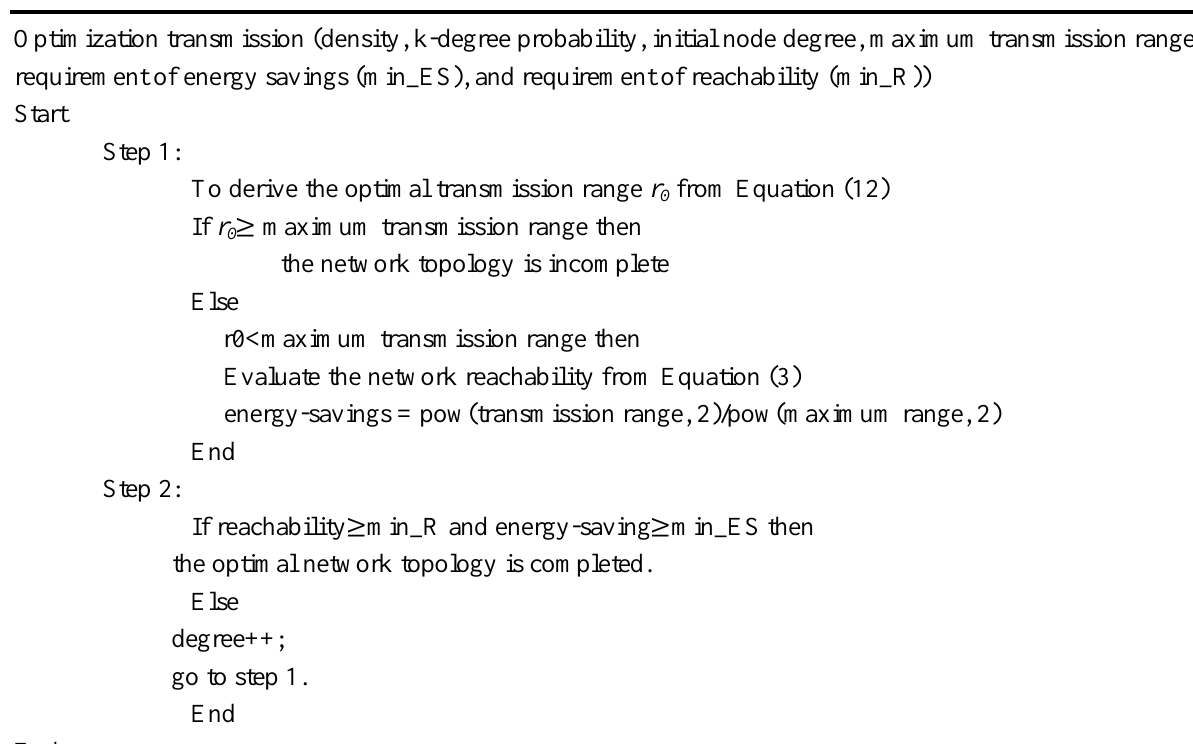
Algorithm 1. The pseudo code of the adjustment model of the transmission